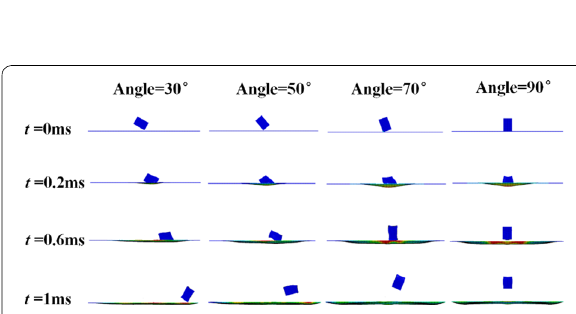
Figure 5 Dynamic responses of the aluminium alloy plate and the cuboid fragment (impact velocity